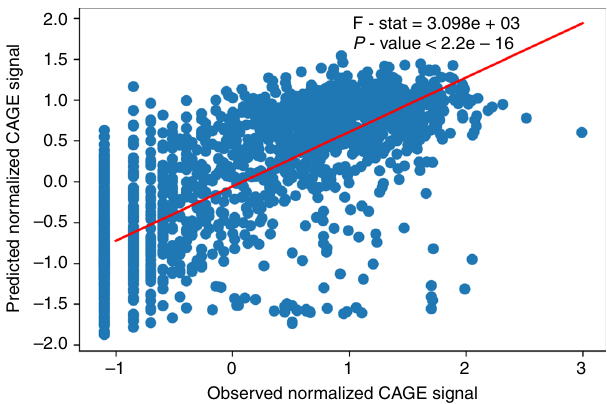
Fig. 4 Agreement between predicted and observed CAGE signal. The example illustrates the agreement between predicted and observed CAGE signal on the test chromosome for the joint DNA-chromatin model. The DNA was represented as tri-nucleotide based one-hot encoding. A linear regression (red line) was fi tted in order to test the agreement between predicted and observed CAGE signal. Signi fi cance of the explained variability was tested using an F-test ( P -value < 2.2 × 10 − 16 ; F-stat = 3.098 × 10 3 ,